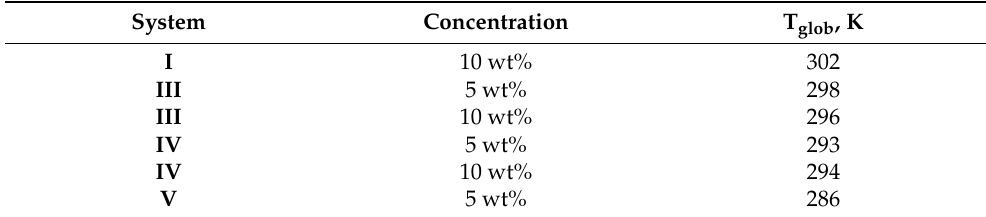
Table 3. Onset temperatures for globule formation in the solutions of P(NIPAM- g -PLA) in the presence of Cu 2+ ions measured via